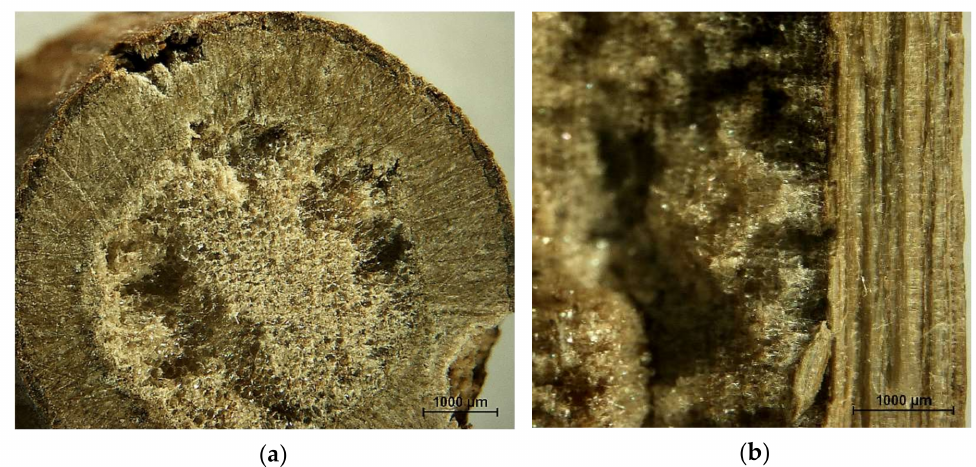
Figure 2. Cross-cut: ( a ) across and ( b ) along the fibers of a raspberry stalk. The cross-cut of chokeberry (Figure 3) can be referred to as broadleaf plants. The year rings (Figure 3a) are clearly visible, and wood rays are going horizontally between bark and pith (Figure 3b; bark on the left, pith on the right). It is worth pointing out that the pith is also in foam form, which was found for raspberry stalks, but here the amount of foam pith was significantly lower than for